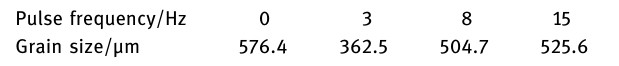
Table 1: The average grain size of brass alloy with and without